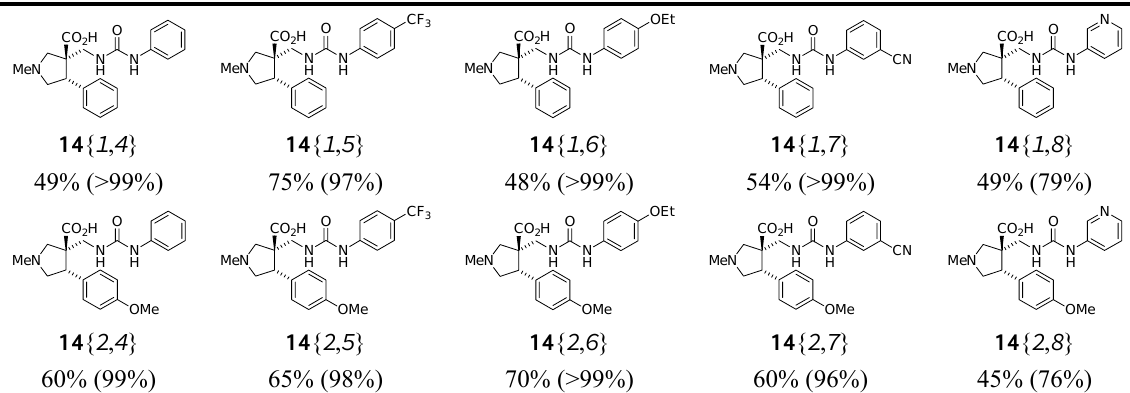
Table 5. Parallel synthesis of α -ureidomethyl acid library 14 { 1 – 6 , 4 – 8 } a,b